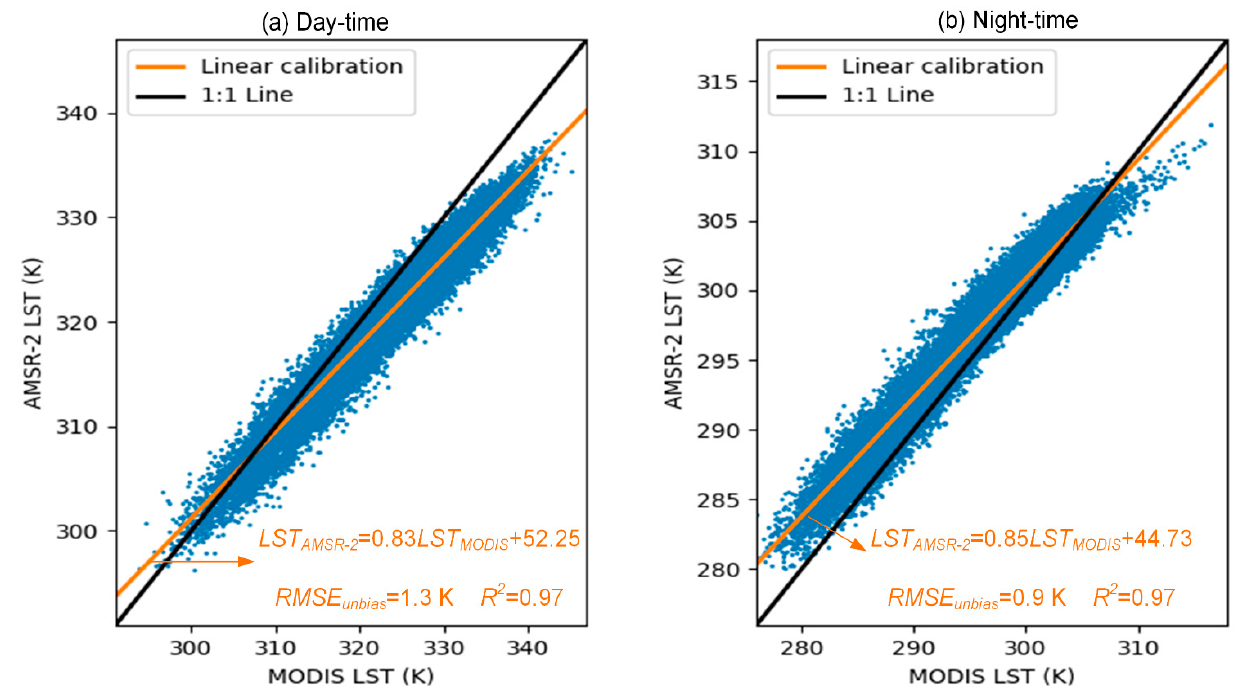
Figure 3. Comparison between land surface temperature (LST) data derived from passive microwave observations made by AMSR-2 and gridded into 25-km pixels, and LSTs derived from near simultaneous Aqua MODIS observations (i.e., the MYD21A1 LST product) averaged over the same 25-km grid cells during the study period. Ordinary least squares linear best fits and the 1:1 lines are shown in solid orange and black respectively.